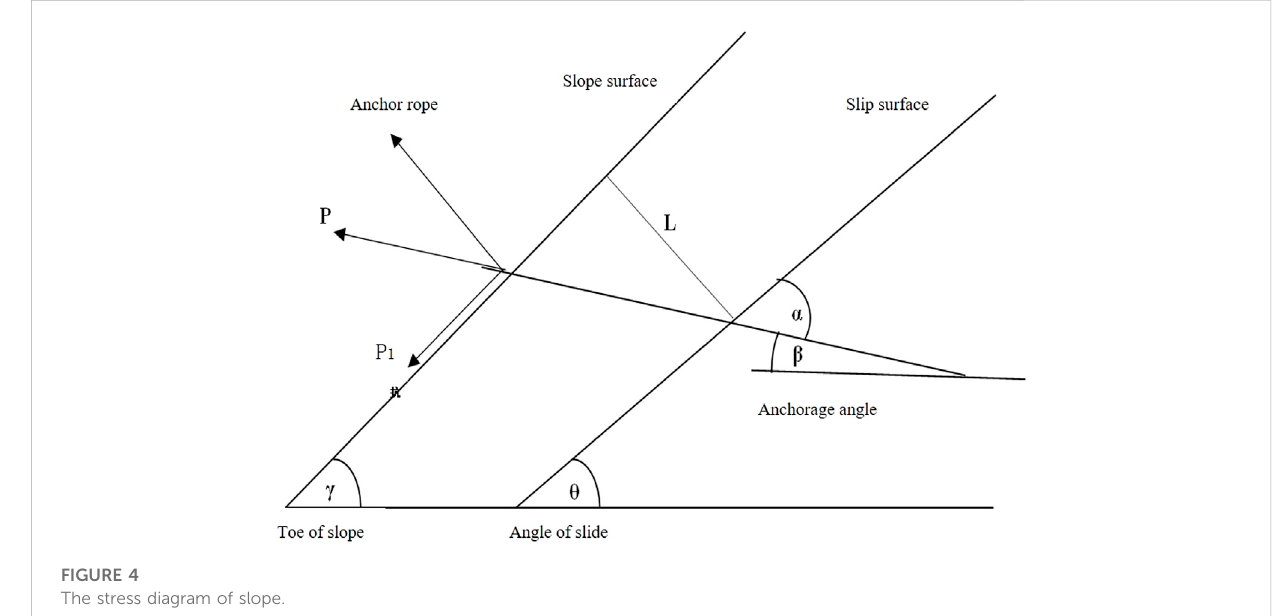
FIGURE 4 The stress diagram of slope.